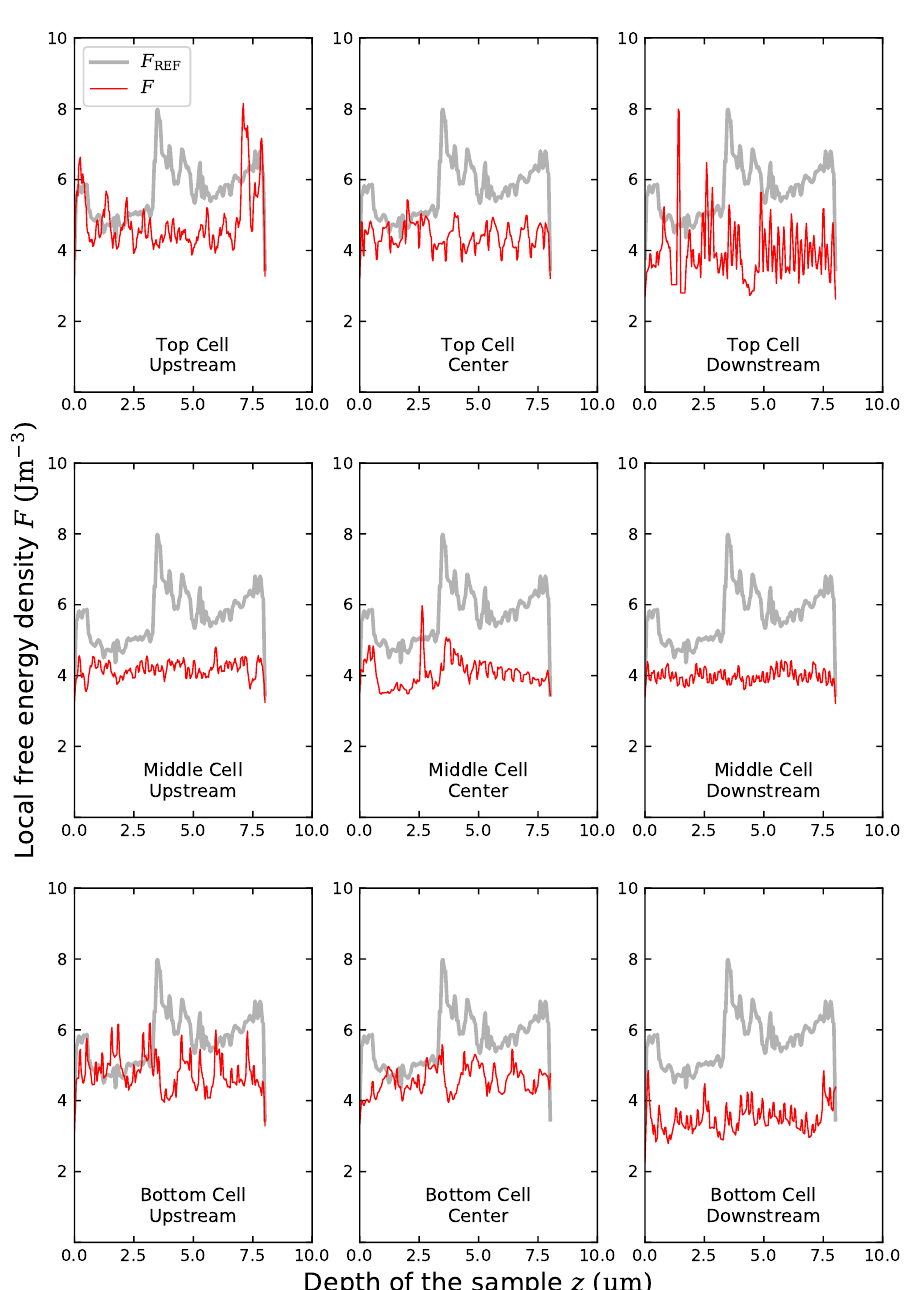
Figure 7. Local free energy density distribution in the reference cell ( F REF ), and in the samples recovered after the long term performance experiment ( F